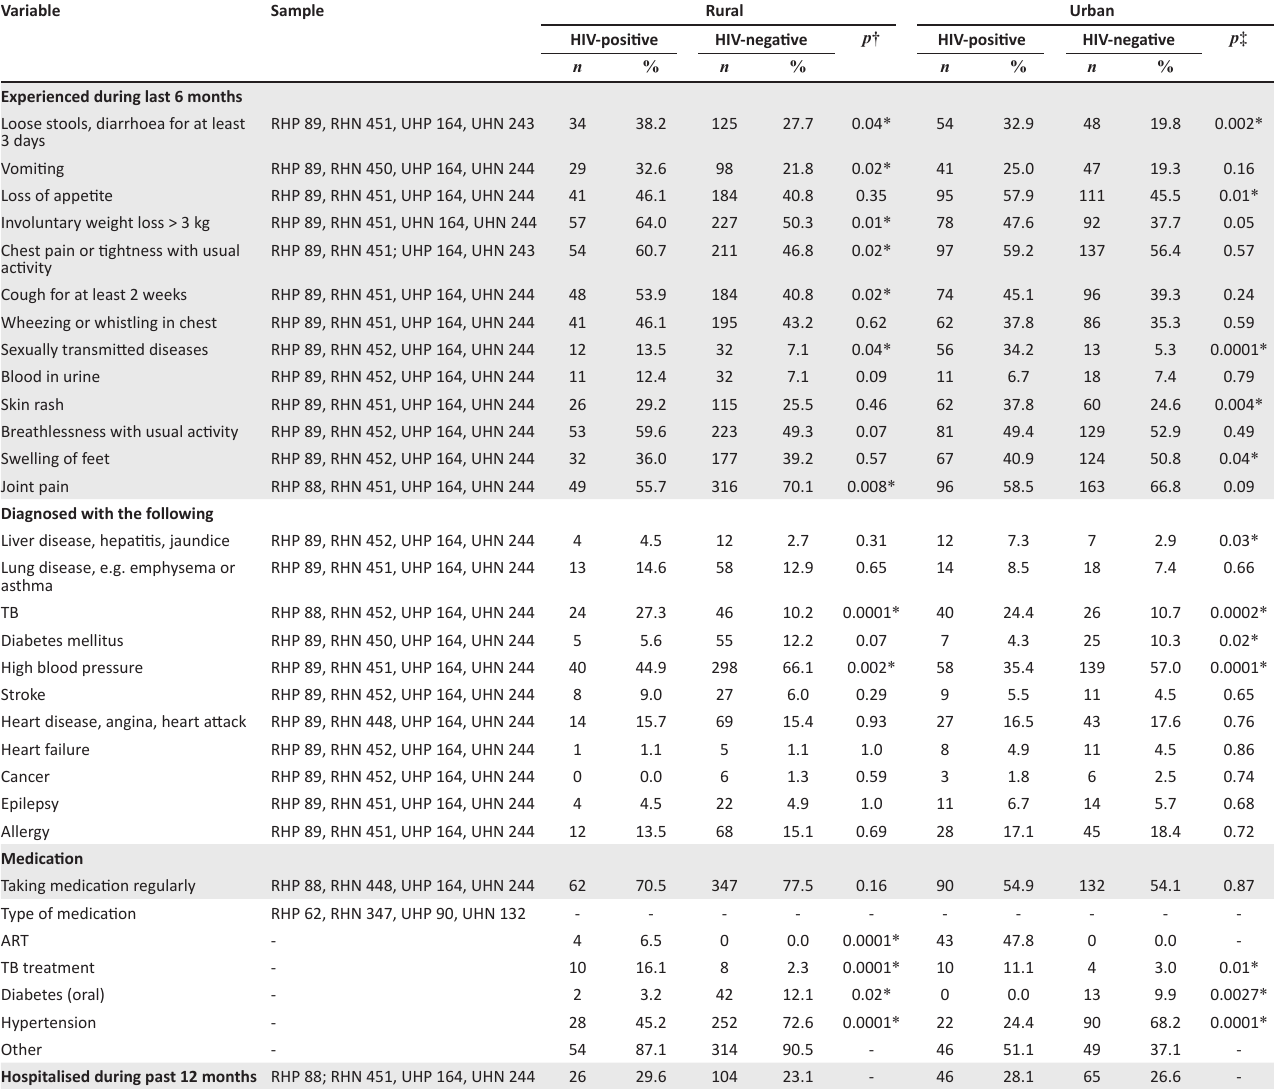
TABLE 3: Reported symptoms, diagnoses and medication use. Variable